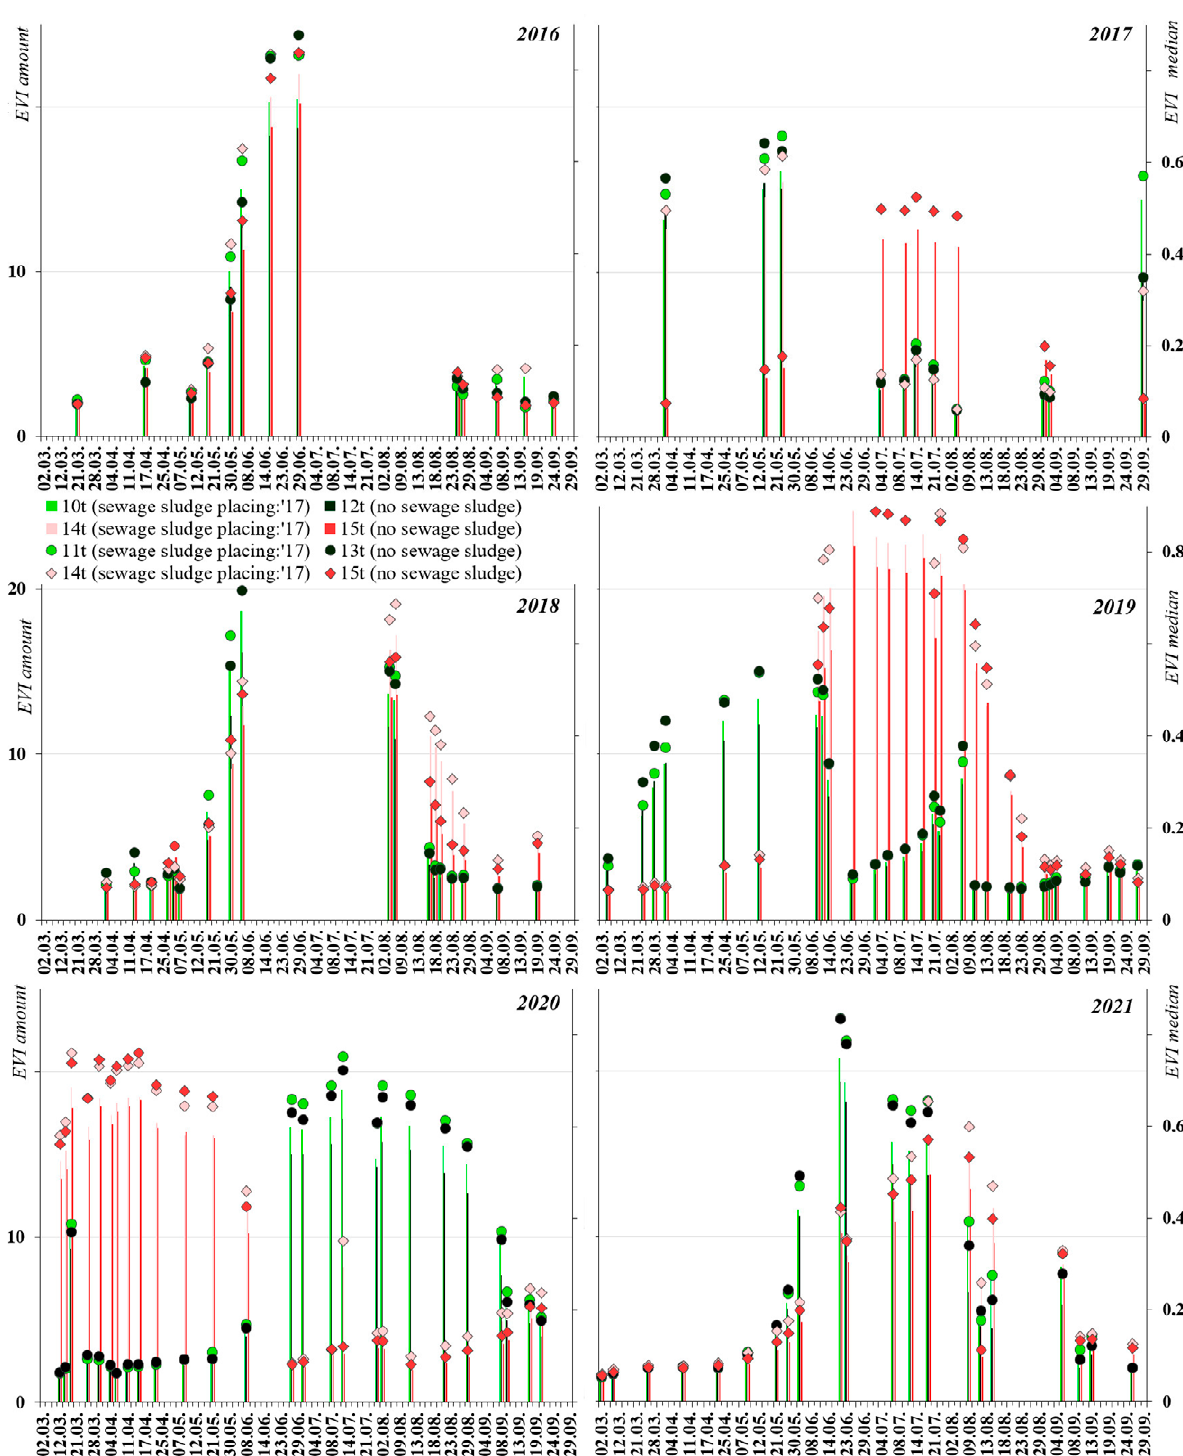
Figure 6. EVI values of quadrates of Kardos study site between 2016 and 2021 (points: EVI median, columns: EVI total) (10t-11t and 14t: sewage sludge placing in 2017; 12t-13t and 15t: no sewage